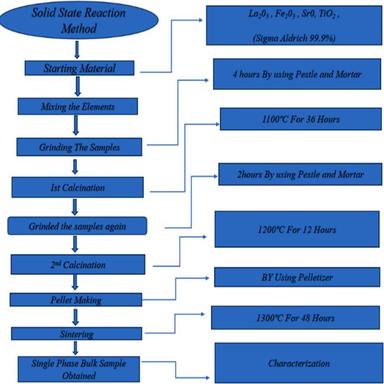
Solid state synthesis route for the preparation of La2SrFe2TiO9.